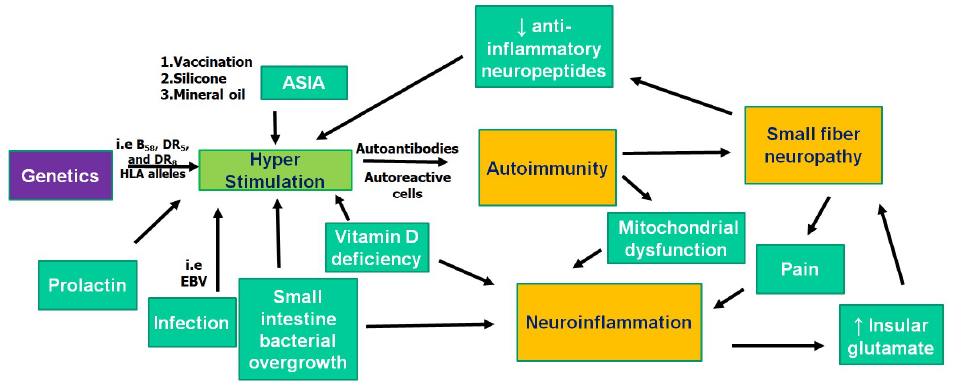
Figure 2. The relationship between three major links of the pathogenesis of FM. The hyperstimulation of the immune system, in addition to genetic predisposition, increases the risk of breach of self- tolerance. Neuroinflammation in FM was interpreted both as “neurogenic,” presumably triggered